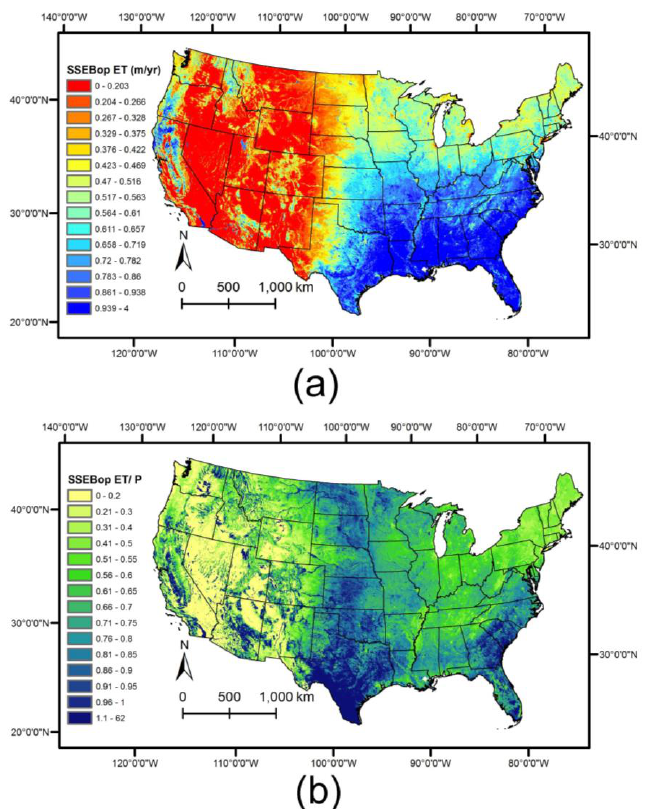
Figure 3. Operational Simplified Surface Energy Balance (SSEBop) ET data. ( a ) Average annual